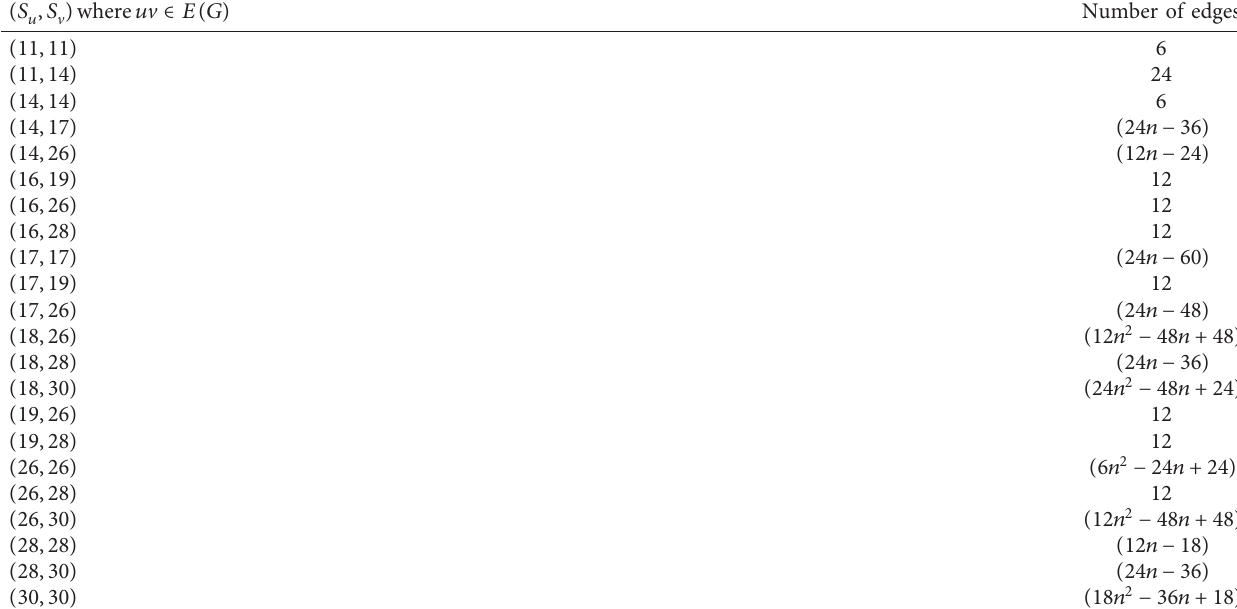
Table 6: Edge partition of SSL ( n ) centred on the number of the vertices of the degree lying at the unit distance from the end vertices of each